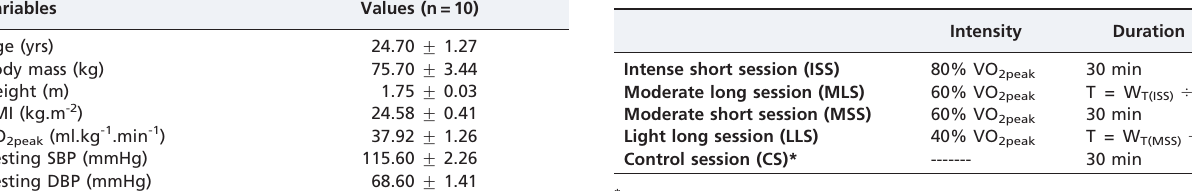
Table 2 - Description of the exercise